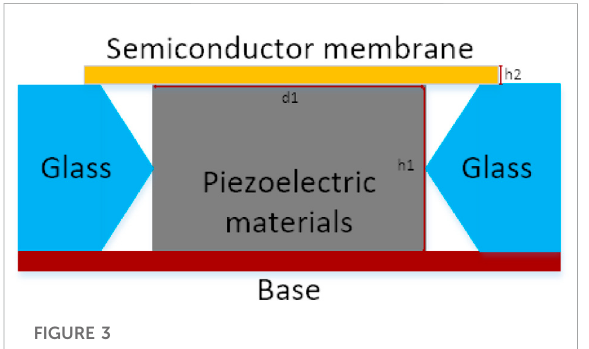
FIGURE 3 Schematic diagram of X-Z plane of sensor structure.